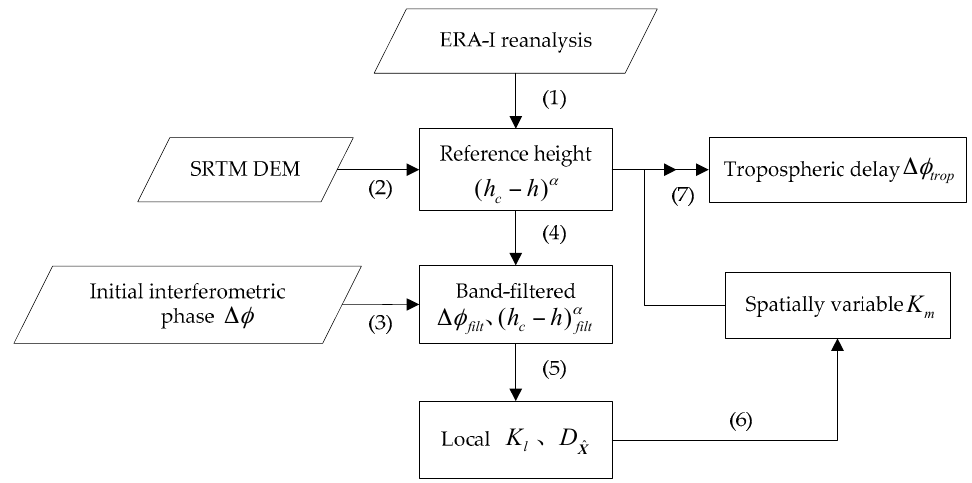
Figure 4. Flow chart of tropospheric delay estimation using the PLE method for an interferogram: (1) log-log fitting Equation (8) to obtain α and h c based on ERA-I reanalysis; (2) extracting elevation h for all pixels from SRTM DEM; (3) and (4) band filtering in the corresponding spatial wavelength; (5) expanded robust estimation for local K l (Equation (9)) and D ˆX (Equation (13)) in each window; (6) local K l values are extrapolated to each pixel using the multi-weighted method (Equations (14)–(16)); and (7) calculating the final tropospheric delay using Equation (10).